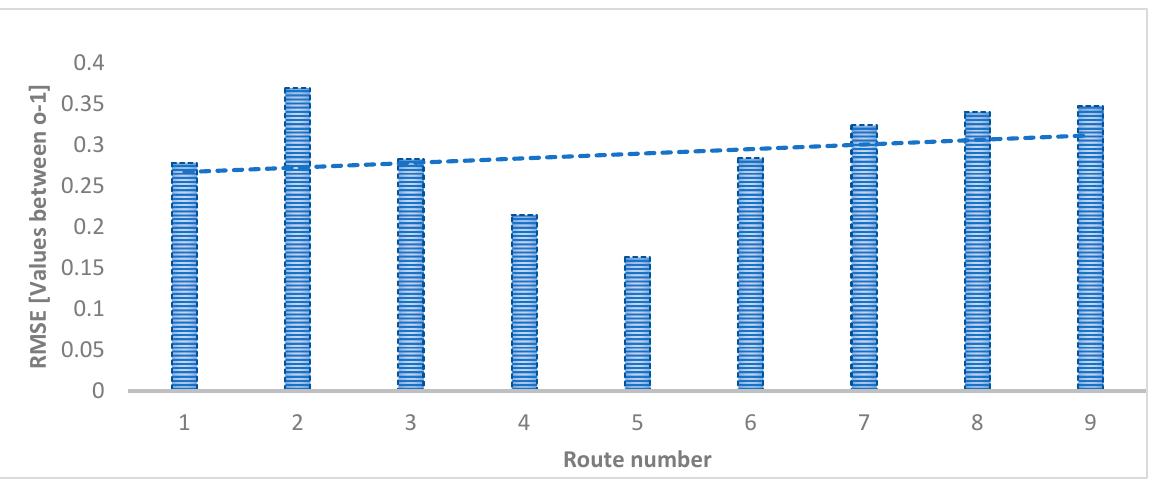
Figure 9. Average value of RMSE for each